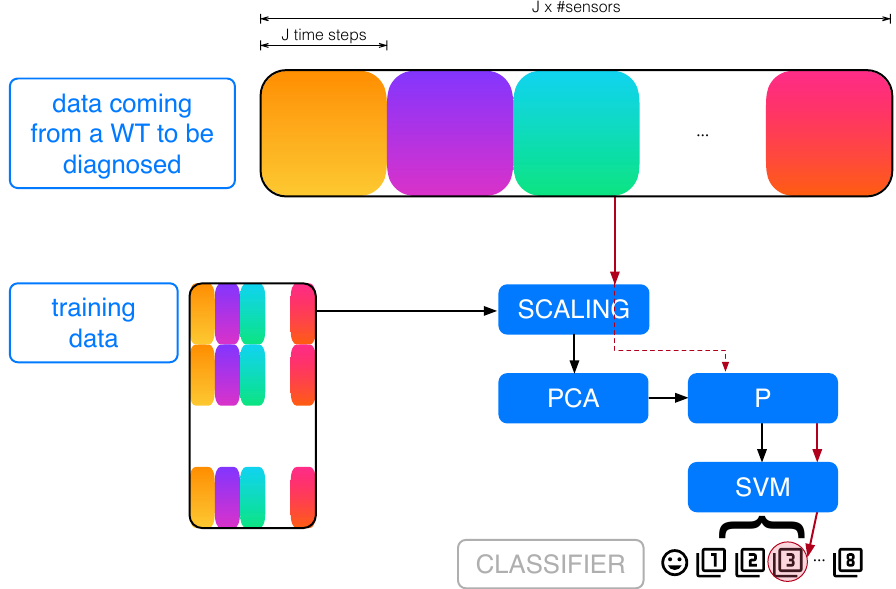
Figure 4. Data coming from a wind turbine (WT) to be diagnosed are first scaled, then projected into the vectorial space spanned by the first principal components, and finally the projection enters the